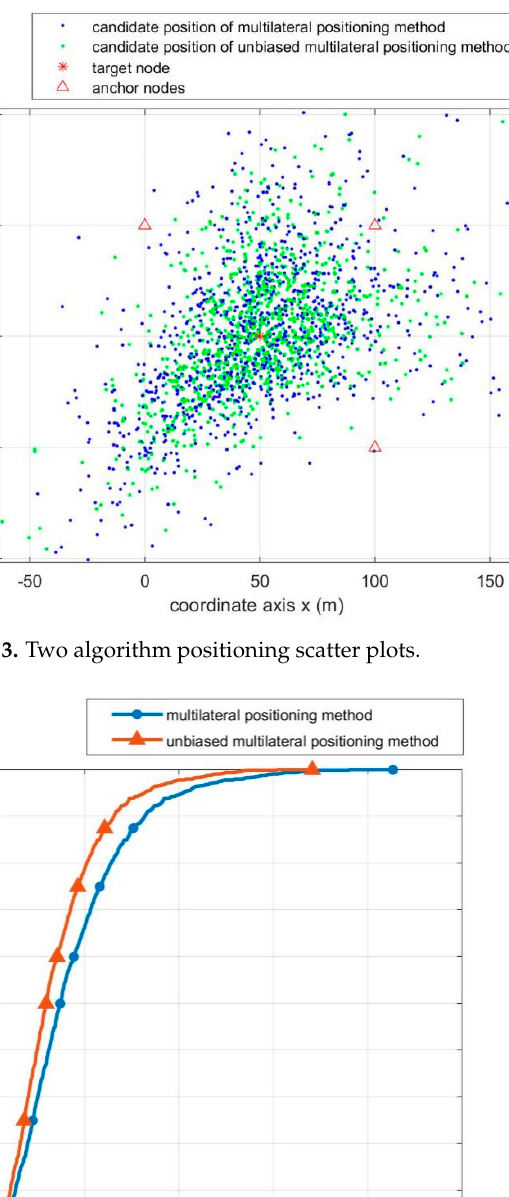
Figure 4. CDF (Cumulative Distribution Function) graph of two algorithms.